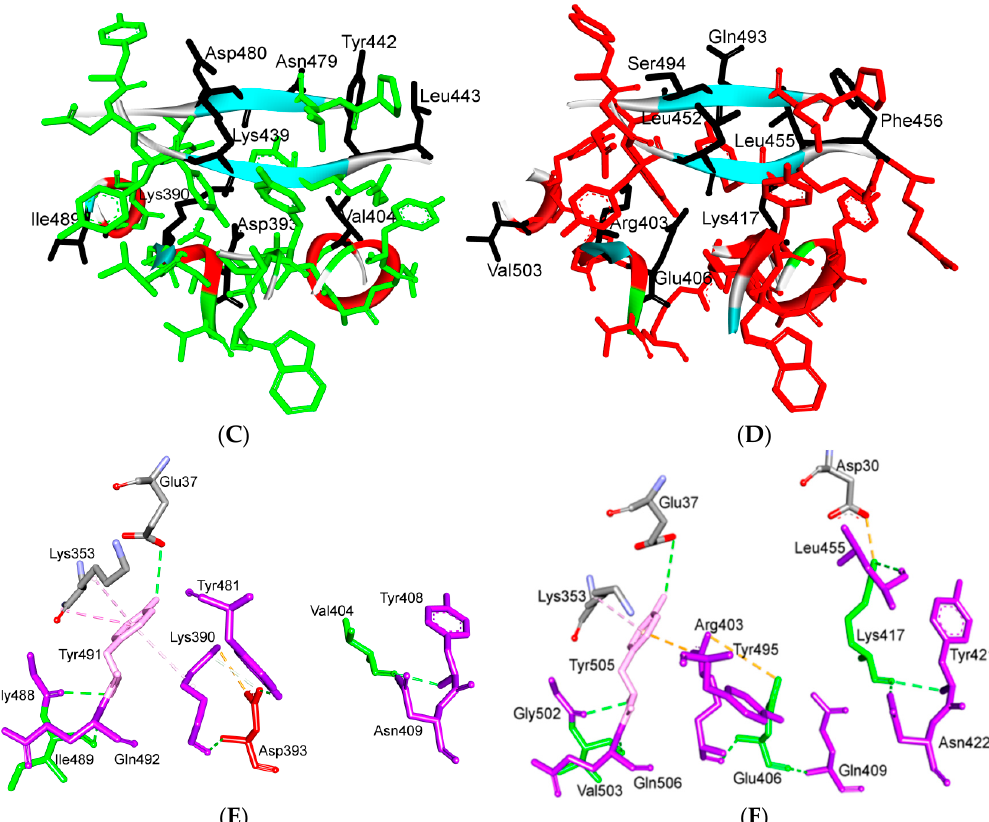
Figure 5. Structure of TR2 and ridge regions in both SARS-CoV and SARS-CoV-2, and their interactions to ACE2. ( A , B ) show the intra-molecular and inter-molecular contacts of TR2 region in SARS-CoV and SARS-CoV-2, respectively. The number of the interactions in TR2 region is noticeably higher in SARS-CoV-2 compared to that of SARS-CoV. The presence of Asn501 in SARS-CoV-2 (instead of Thr487) makes a substantial difference since it is involved in stacking with Tyr41 on ACE2. This stacking liberates Gln498 (instead of Tyr484 in SARS-CoV) to make a strong hydrogen bond with Gln42 of ACE2. ( C , D ) show the environment of the ridge and upper core regions of SARS-CoV and SARS-CoV-2, respectively. The residues that are labelled in black show the amino acids in this region that differ between SARS-CoV and SARS-CoV-2. ( E , F ) show the main amino acids in the upper core region. The green and red residues indicate those in α -helices and 3/10 helices in this region, respectively. These amino acids are in contact with other amino acids in the RBM (pink) and RBD (violet). Lys417 is the main player in this region, since it is involved in electrostatic interactions with Asp30 from ACE2. 3D models were created using Discovery Studio (version 2.5.5, Biovia, San Diego, CA, USA).